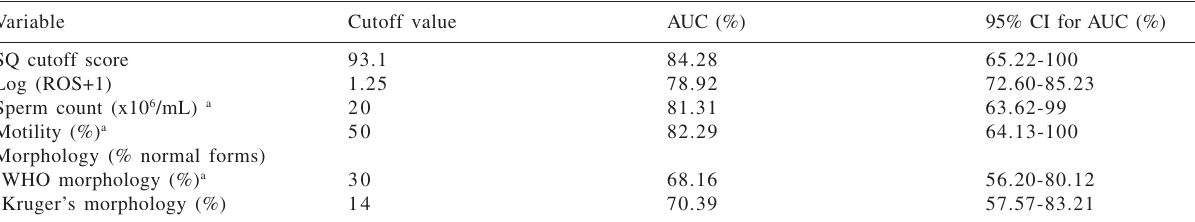
Table 4 - Areas under the curve (AUC) for semen quality (SQ) score and various sperm parameters Variable Cutoff